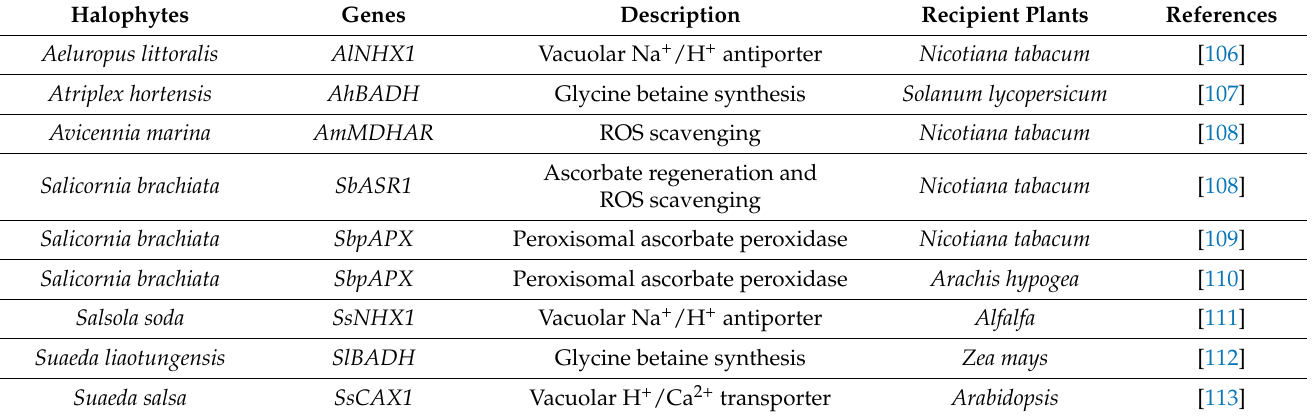
Table 3. Salt-responsive genes present in halophytes and recipient